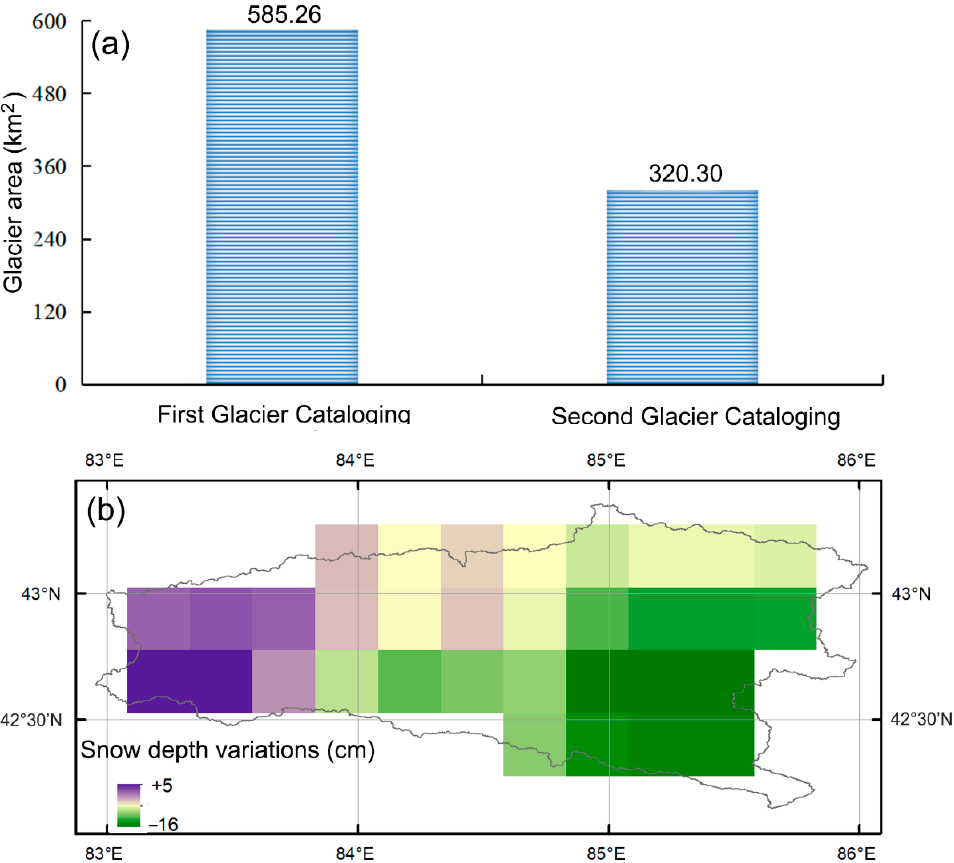
Figure 7. Glacier and snow changes in KRB: ( a ) changes in the glacier areas; and ( b ) changes in snow depth (January 2015 vs. January 1980). The data in ( a ) refers to Bai [75].